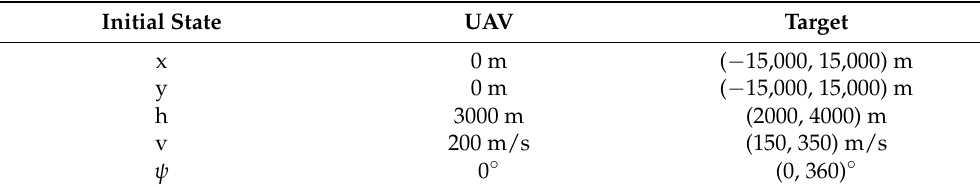
Table 3. Initial state of the UAV and target during training.